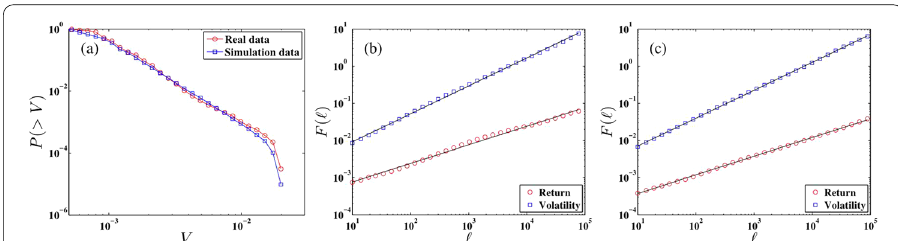
Fig. 6 Model validation. a Empirical cumulative distributions of volatility of simulated data and stock 000001. Both distributions have power‑law tails. b DMA fluctuation functions F (ℓ) of the return and volatility series for simulation data. c DMA fluctuation functions F (ℓ) of the return and volatility series of Stock 000001. The curves of volatility in b , c have been shifted vertically for